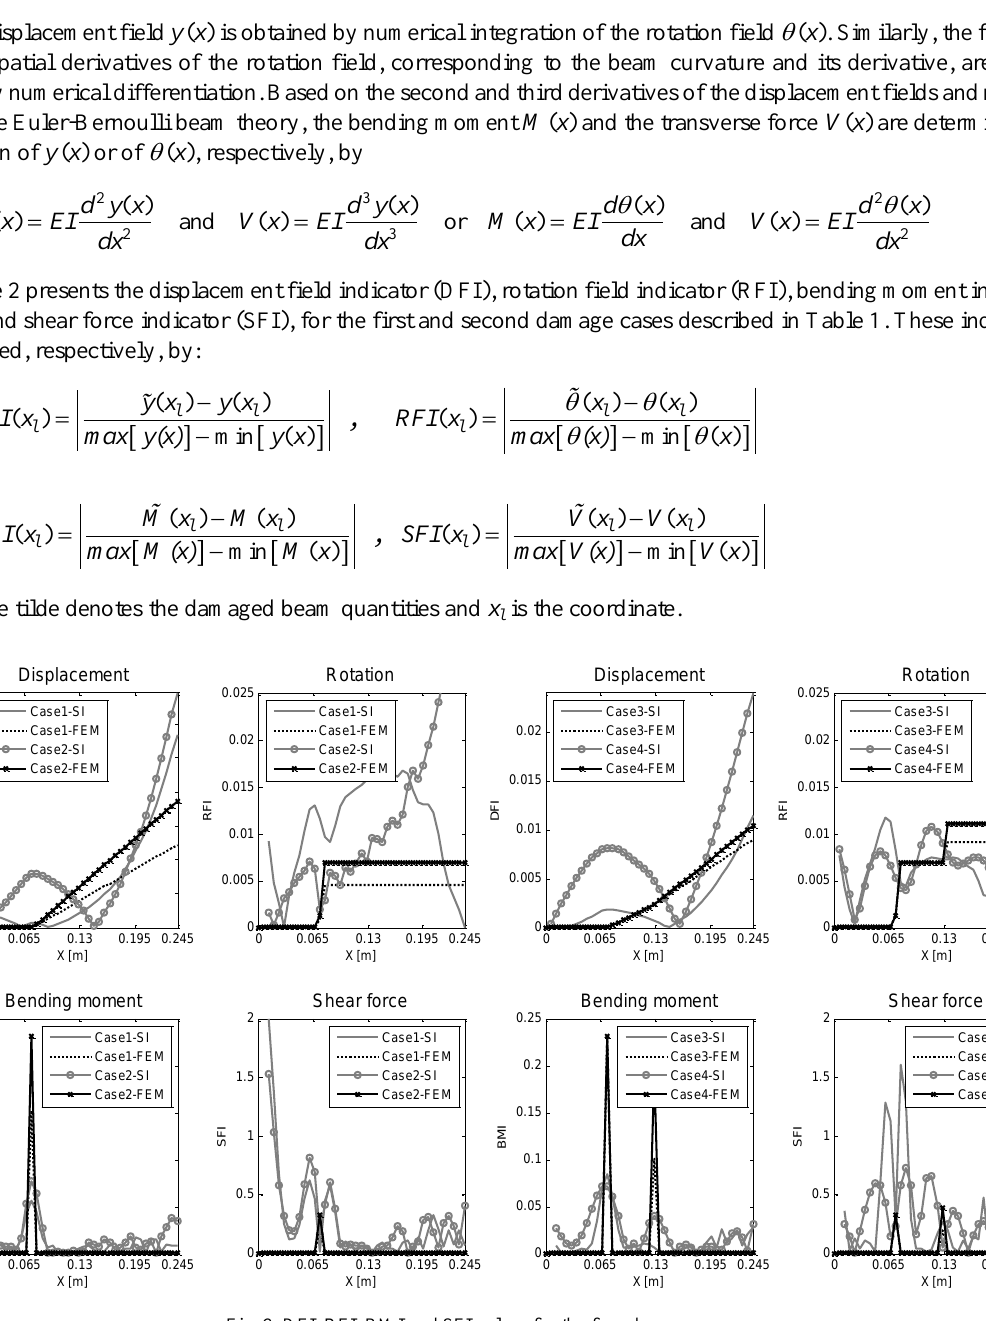
Fig. 2. DFI, RFI, BMI and SFI values for the four damage